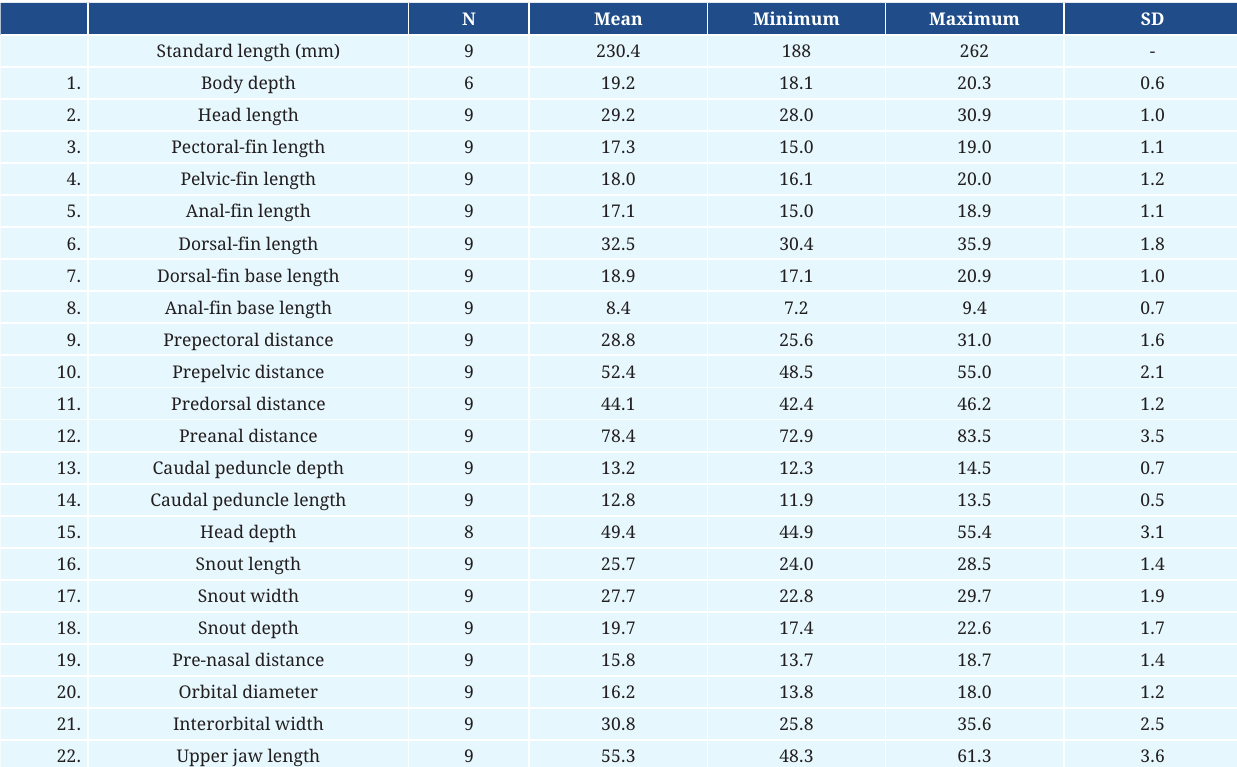
TABLE 2 | Morphometric data of Hoplias misionera from the Amazon basin; values 1 - 14 are percentages of the standard length and values 15-22 are percentages of head length. N = number of specimens; SD = standard